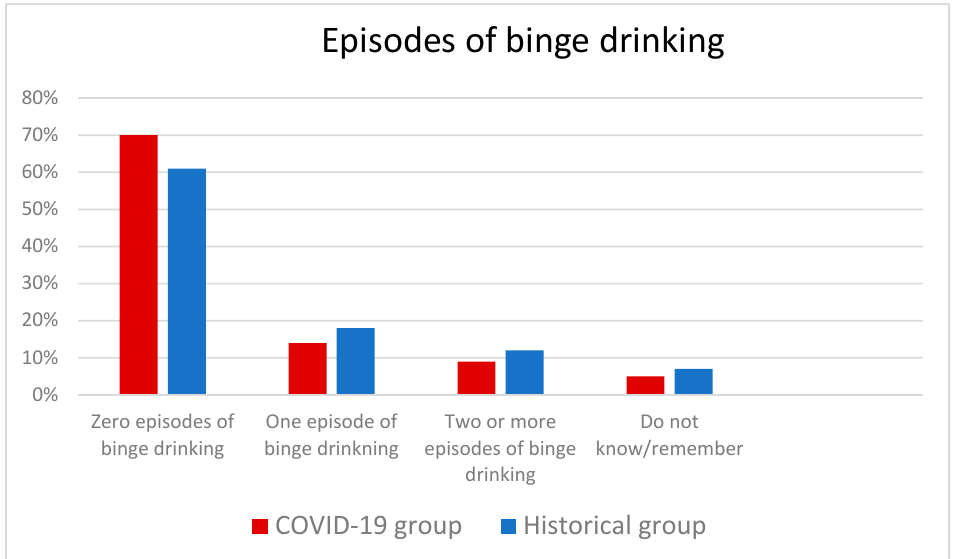
Figure 3. The distribution of binge drinking episodes in the COVID ‐ 19 group and the Historical group. The difference across the groups was significant ( p = 0.004).